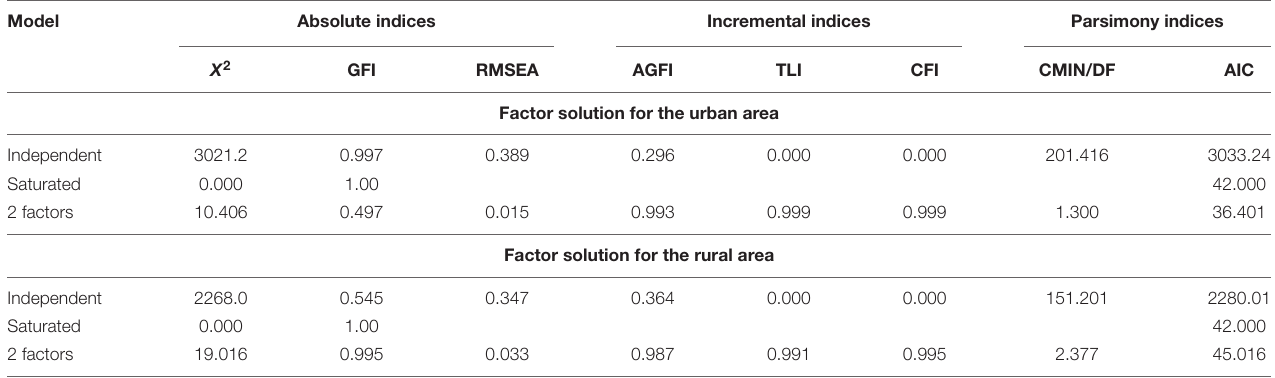
TABLE 4 | Absolute, incremental and parsimony indices for the generated models, confirmatory factor analysis for urban and rural areas (* p < 0.05).